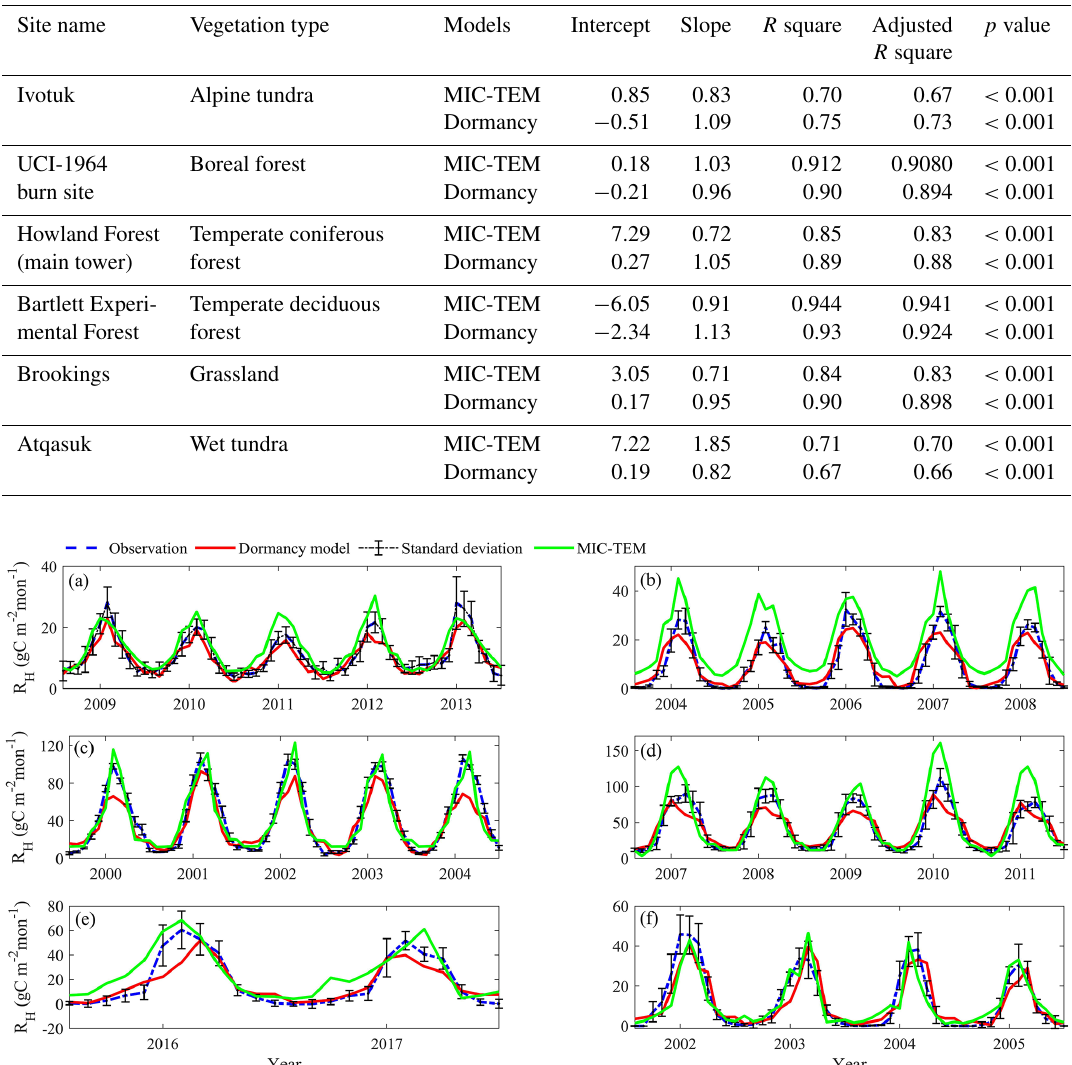
Table 5. Model validation statistics for the dormancy model and MIC-TEM at six sites with NEP data.